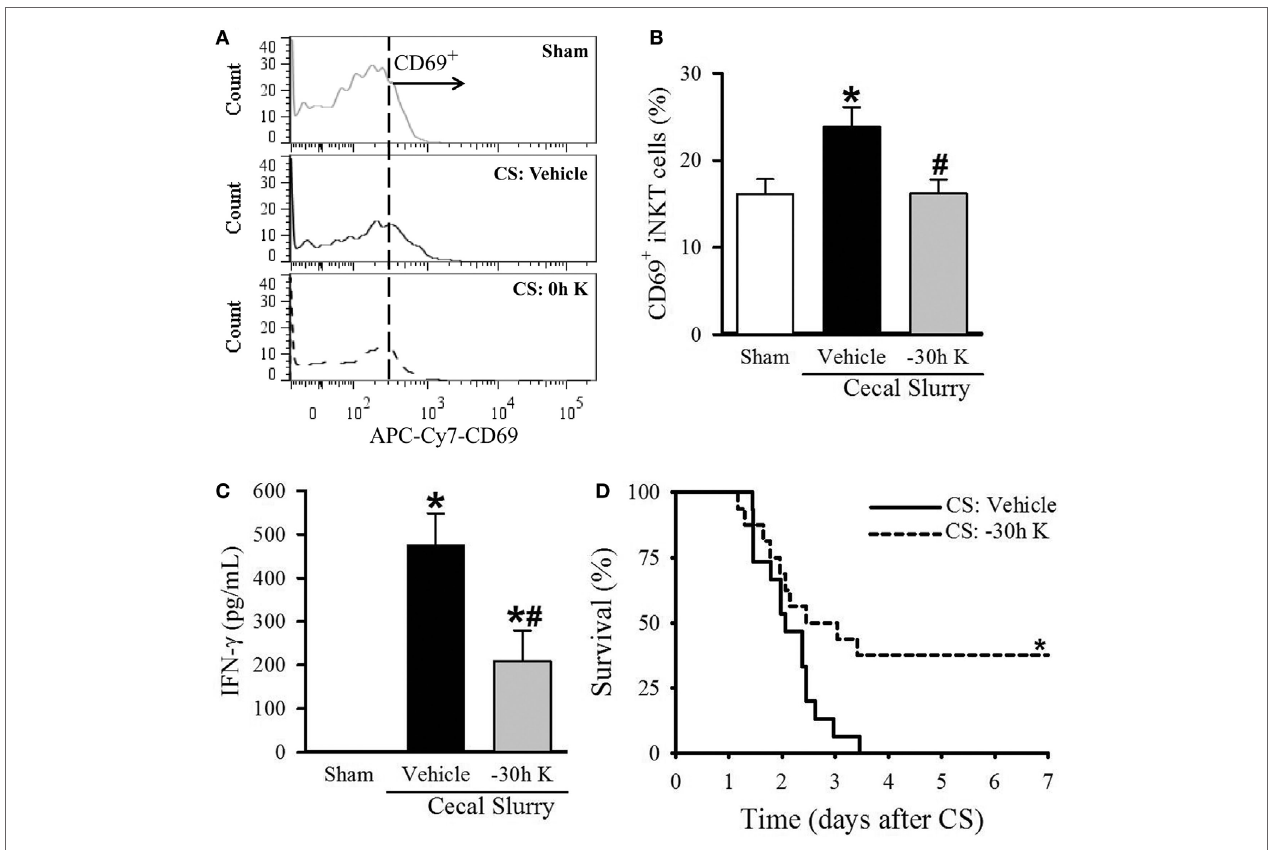
FigUre 4 | Effect of − 30 h KRN treatment on invariant natural killer T (iNKT) activation cell activation and survival in septic neonatal mice. Neonatal C57BL/6 pups received KRN (0.2 µg/g BW) or vehicle (2.5% dimethyl sulfoxide in PBS) intraperitoneal (i.p.) 30 h prior to ( − 30 h K) sepsis induction. Sepsis was then induced by i.p. injection of cecal slurry (CS, 0.9 mg/g BW). Serum and liver were harvested 10 h later. (a) Representative histogram of CD69 expression on hepatic iNKT cells. (B) Flow cytometric analysis of surface CD69 expression on gated hepatic iNKT cells. (c) Interferon (IFN)- γ levels in the serum were measured by enzyme-linked immunosorbent assay. Data expressed as mean ± SEM ( n = 5–9 per group) and compared by one-way analysis of variance (* p < 0.05 vs. Sham, # p < 0.05 vs. Vehicle). (D) Another set of pups received the same dose of KRN or vehicle 30 h prior to sepsis induction by CS (0.175 mg/g) and survival was monitored for 7 days ( n = 15–16 per group, * p = 0.026 vs. Vehicle, log-rank